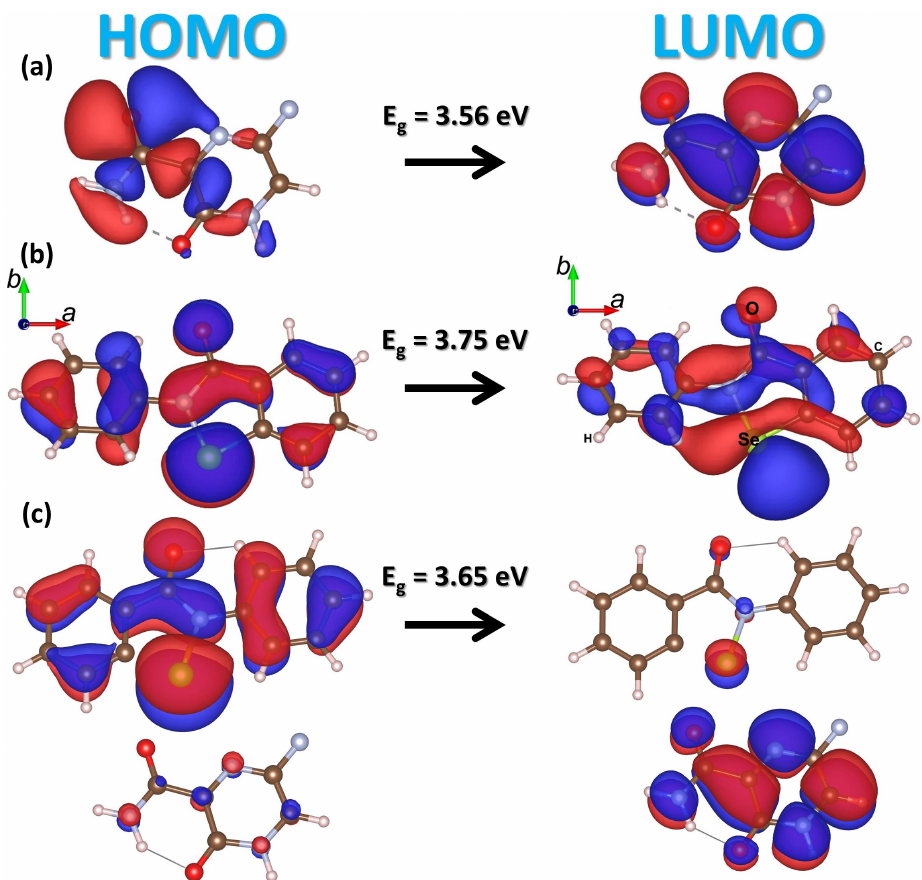
Figure 2. Three dimensional (3D)–view of the highest occupied (HOMO) and lowest unoccupied (LUMO) molecular orbitals and energy gap of ( a ) favipiravir, ( b ) ebselen, and ( c ) hybrid free molecules, respectively. The red and blue colors illustrate isosurface electron accumulation and depletion ( ρ = ±9.5 × 10 − 5 ¯e/Å 3 ),